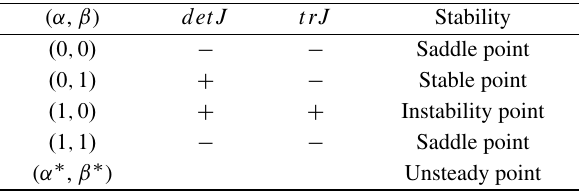
Table 3 Stability of equilibrium points in Scenario 1.